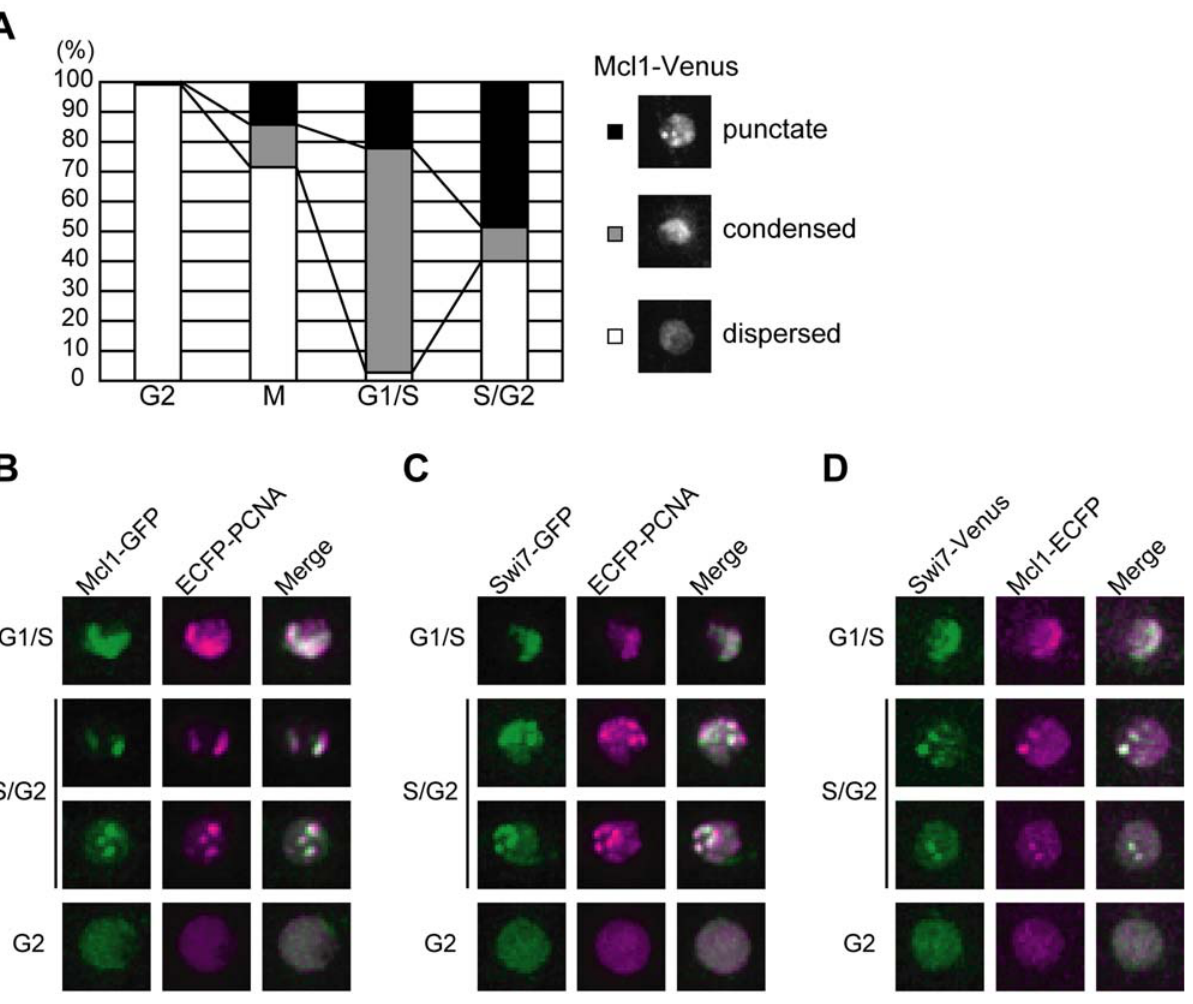
Figure 7. Mcl1 localizes to replication foci during S-phase. ( A ) Mcl1 changes its nuclear localization during S-phase. Cells expressing Mcl1- Venus from the endogenous locus were classified into 4 cell cycle stages according to their morphology. The percentage of cells showing punctate (closed bar), condensed (shaded bar), and dispersed (open bar) localization of Mcl1-Venus in various cell cycle stages are shown (left panel). Representative photographs of each localization pattern are shown (right panel). ( B–D ) Mcl1 and Swi7 colocalize with PCNA in the S-phase nucleus. Mcl1-GFP and ECFP-PCNA (B), Swi7-GFP and ECFP-PCNA (C), and Swi7-Venus and Mcl1-ECFP (D) are shown. Merged images are also shown.